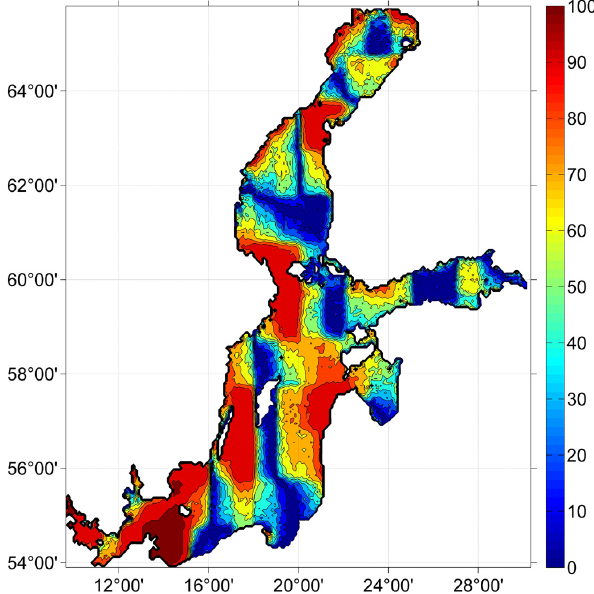
Fig. 5. Statistical significance (%) of the changes presented in Fig. 4 in terms of 100 × ( 1– p ), where p is the relevant p-value for the particular sea